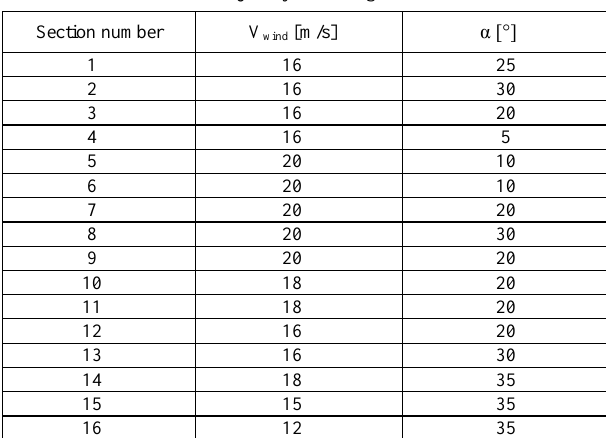
Table 1. Data on the wind speed and its wind direction relative to the trajectory of the flight Section